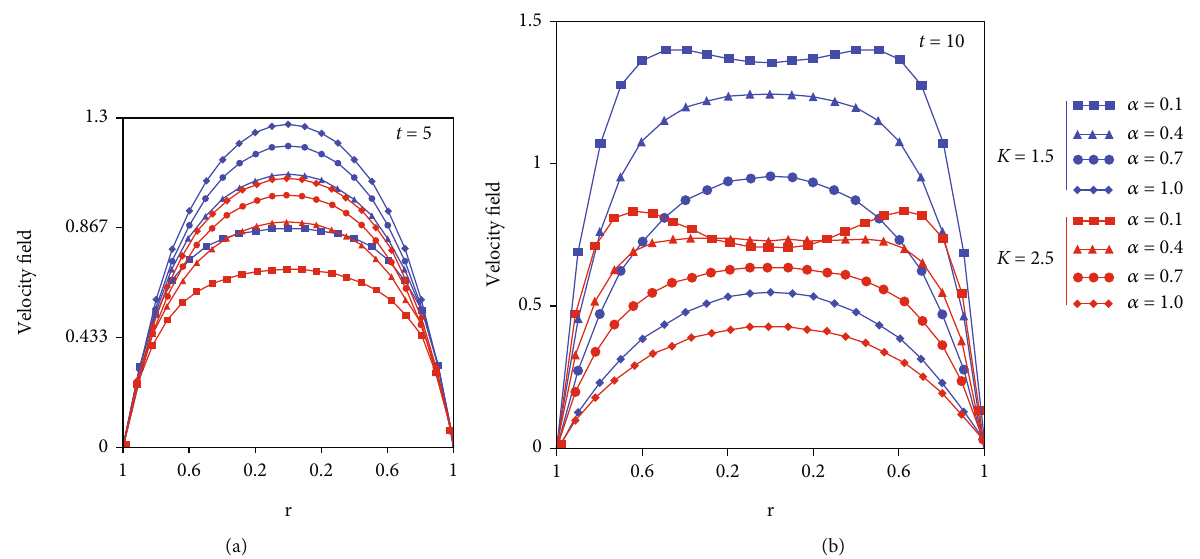
Figure 4: Pro fi les of dimensionless velocity for α versus r at Re = 2 : 5, Ha = 0 : 5, K = 1 : 5, 2 : 5, n = 0 : 8, for small and large values of time t